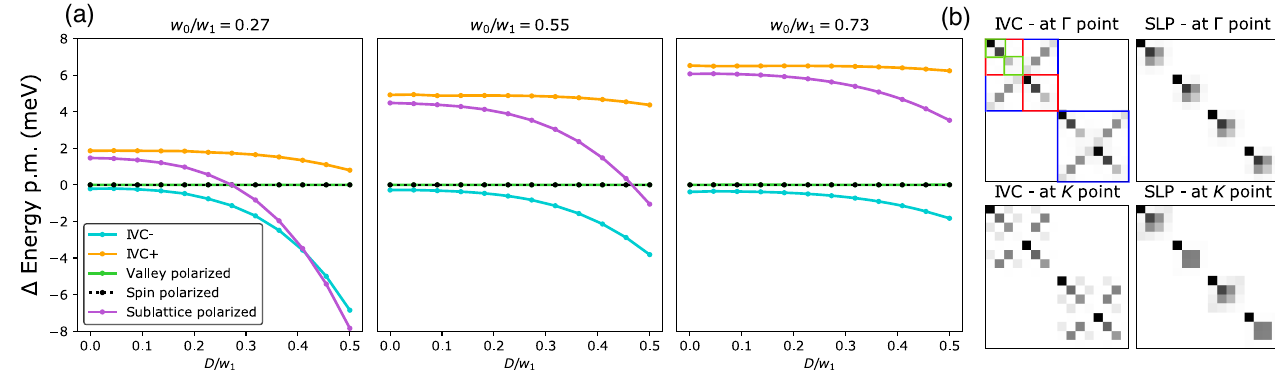
FIG. 5. (a) Line cuts for fixed w 0 showing the energy of our self-consistent solutions relative to a SP state as a function of D 0 . We use w 0 ¼ 124 meV and four bands per spin and valley, with dielectric constant ϵ ¼ 7 and screening distance d ¼ 40 nm. Full energies as a function of w 0 and D 0 can be found in the Supplemental Material [59] Fig. S2. Note that the SLP and SSLP − are not exactly (cid:2) degenerate, as we discuss in the main text, but are plotted as a single line here since the splitting is too small to be visible on the scale of the plot. (b) Matrix form of our converged IVC − and SLP − orders P k for k near the Γ point and near the K point. The matrix structure of P k is organized such that the largest block outlined in blue denotes spin flavor, the next largest block outlined in red denotes valley flavor, the green block denotes upper and lower bands in the continuum model, and the final two boxes denote the graphenelike and TBG-like band in the upper-band box and the TBG-like then graphenelike bands in the lower-band